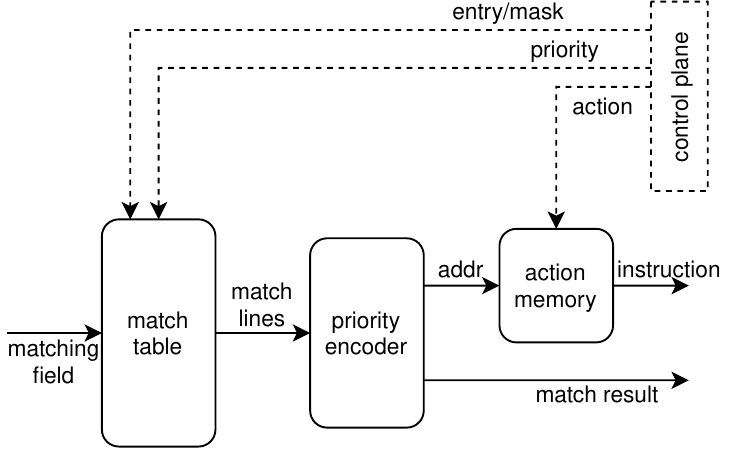
Figure 4. The design of the match